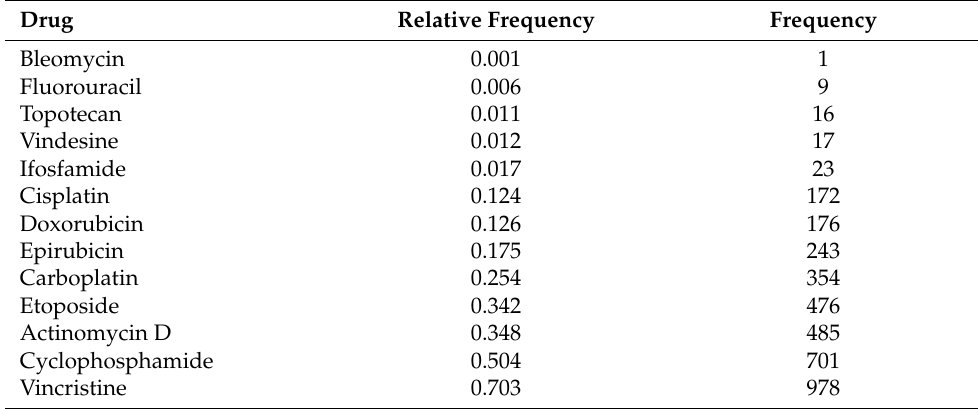
Table 4. Frequency of use of each chemotherapy drug.